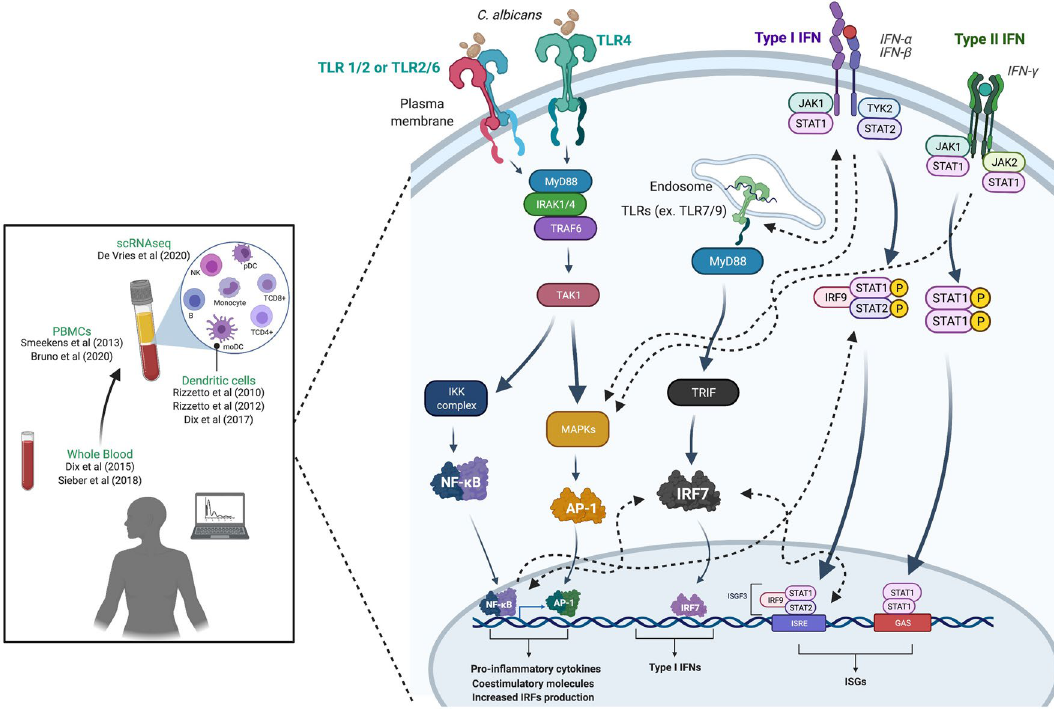
Figure 8. Schematic view summarizing studies and the interplay between TLR and IFN signaling pathways in the immune response to C. albicans. The pathways shown are reported in the literature 50 (created using BioRender.com). IFN, interferon; TLR, Toll-like